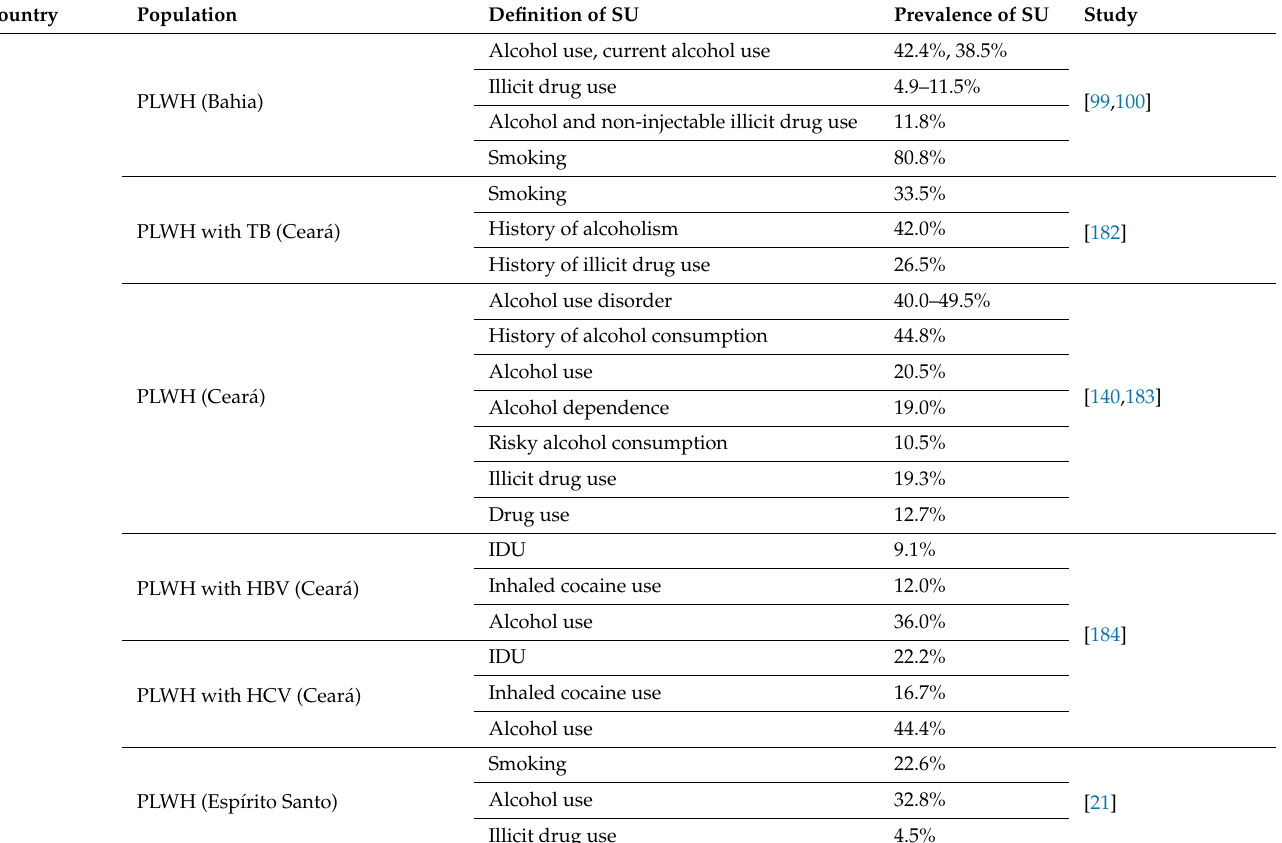
Table 2. Prevalence of substance use (SU) among people living with HIV (PLWH) in Latin America. Country